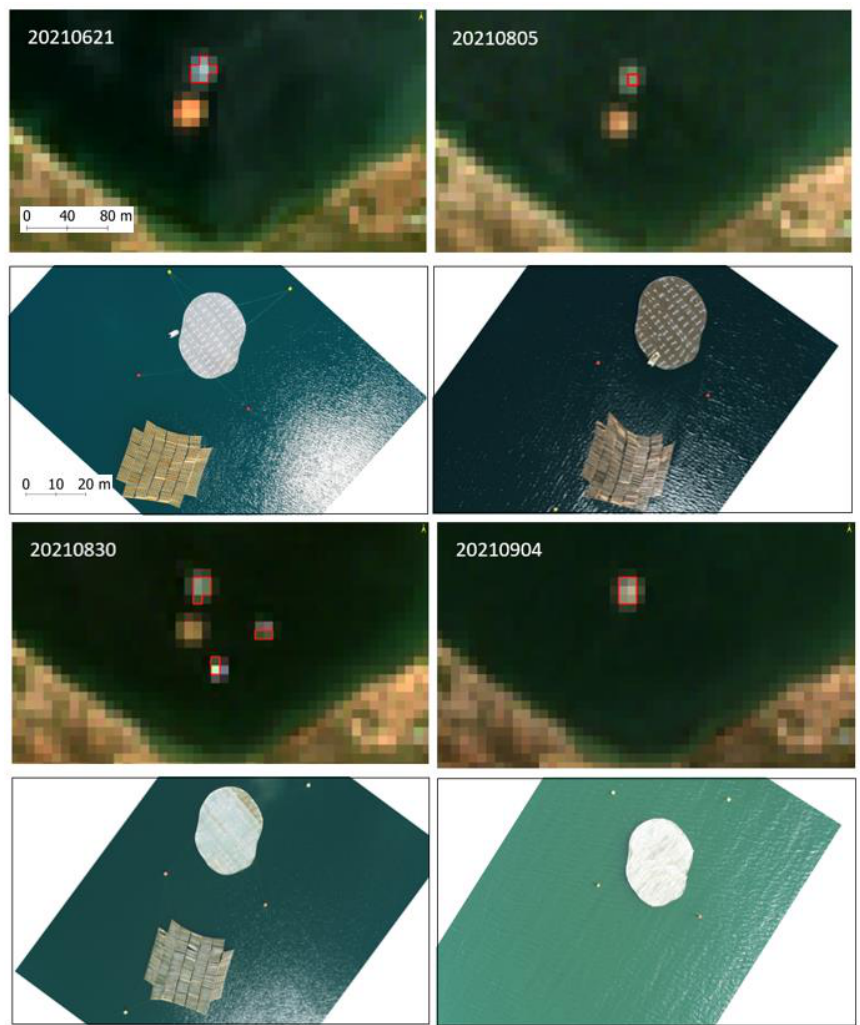
Figure 10. Partial unmixing detection results for: 20210621: floating HDPE target, 20210830: partially submerged HDPE target — the two additional targets are an anchored monohull and a catamaran sailing boat, 20210805: highly biofouled HDPE target, 20210904: mixed target.